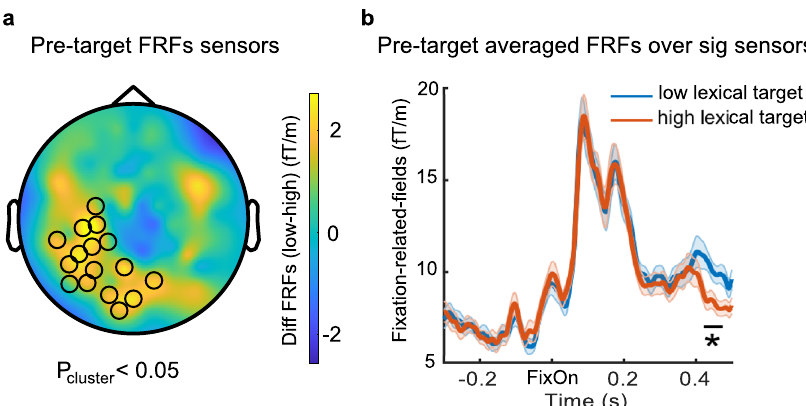
Fig. 6 Fixation-related fi elds for pre-target words. a Topography for the sensors that showed a lexical parafoveal processing effect during pre-target fi xations. The color bar indicates the FRFs difference for pre-target words followed by low compared with high lexical target words ( n = 39, cluster-based permutation with p < 0.05, two-tailed pairwise t -test). b Pre-target averaged FRFs over these signi fi cant sensors for low (solid blue line) and high (solid orange line) lexical target conditions. The shaded areas represent standard error over